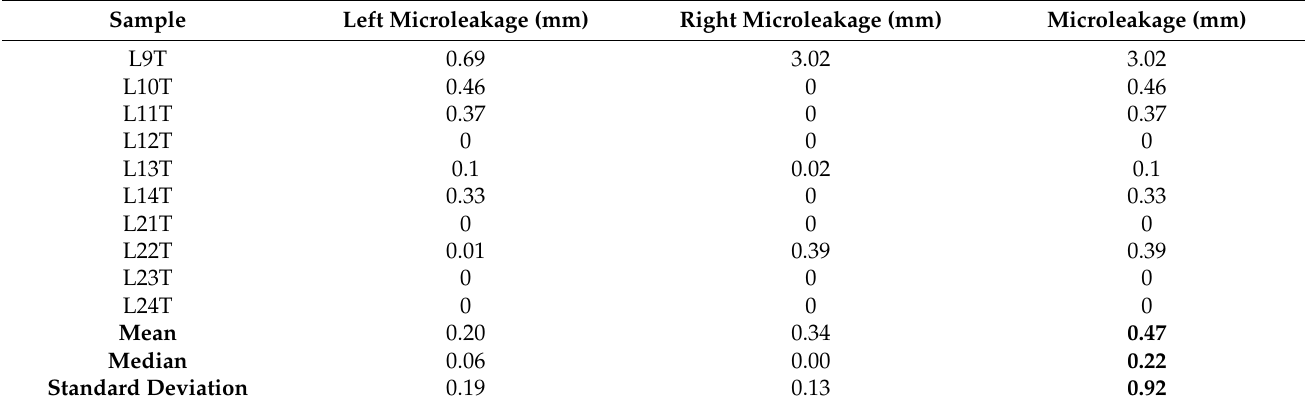
Table 1. Microleakage in the study group.